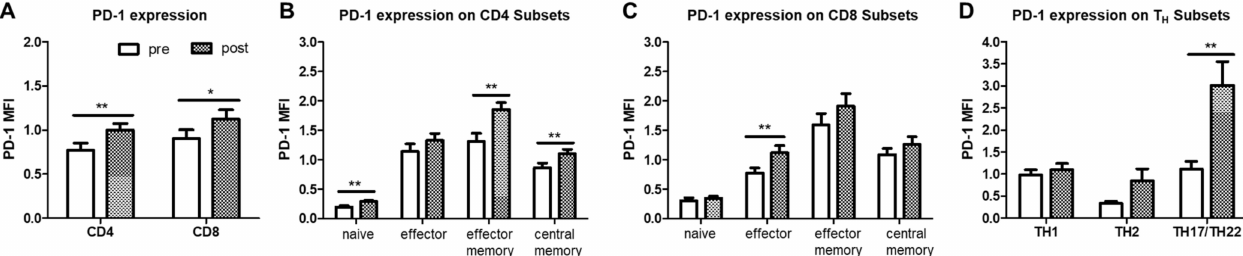
Figure 6. Flow cytometric analysis of CD4 + and CD8 + T cell subsets in PBMC from OSA patients ( n = 22) before and after PAP treatment. ( A ): PD-1 expression intensity (MFI) of whole CD4 + or CD8 + T cell subsets. ( B ): PD-1 expression intensity (MFI) on naïve, effector, effector memory and central memory T cells within CD4 + T cells. ( C ): PD-1 expression intensity (MFI) on naïve, effector, effector memory and central memory T cells within CD8 + T cells. ( D ): PD-1 expression intensity (MFI) on TH1, TH2 or TH17/22 T helper cell subsets. MFI = mean fluorescence intensity. *: p < 0.05; **: p <